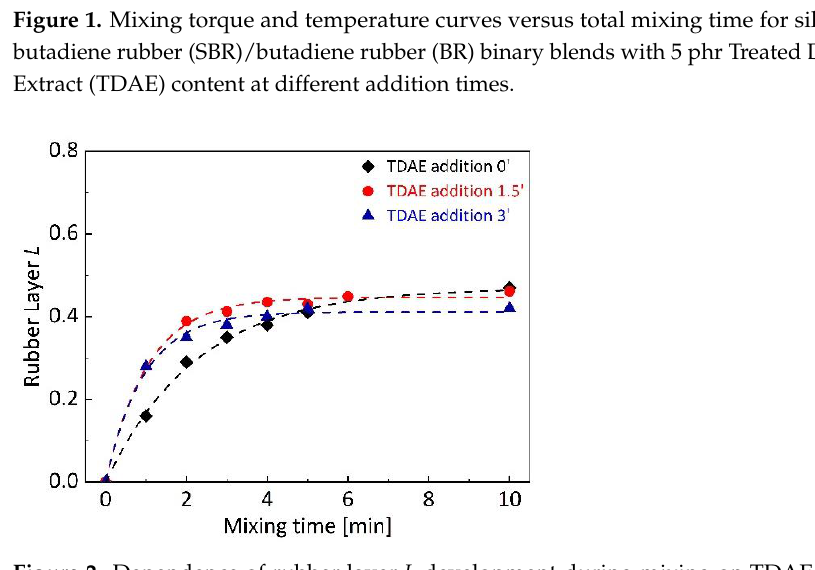
Figure 2. Dependence of rubber layer L development during mixing on TDAE addition time for silica-filled SBR/BR binary blends.